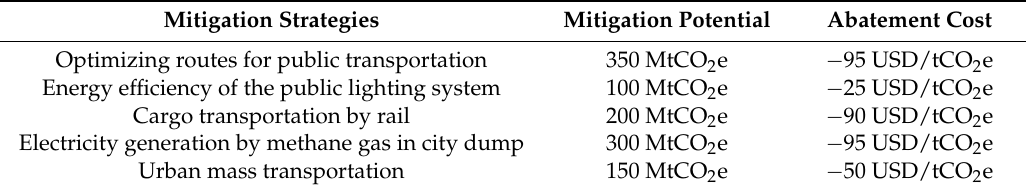
Table 3. Classification of strategies by mitigation potential through Mexico MACC curve for the period 2009–2030. Mitigation